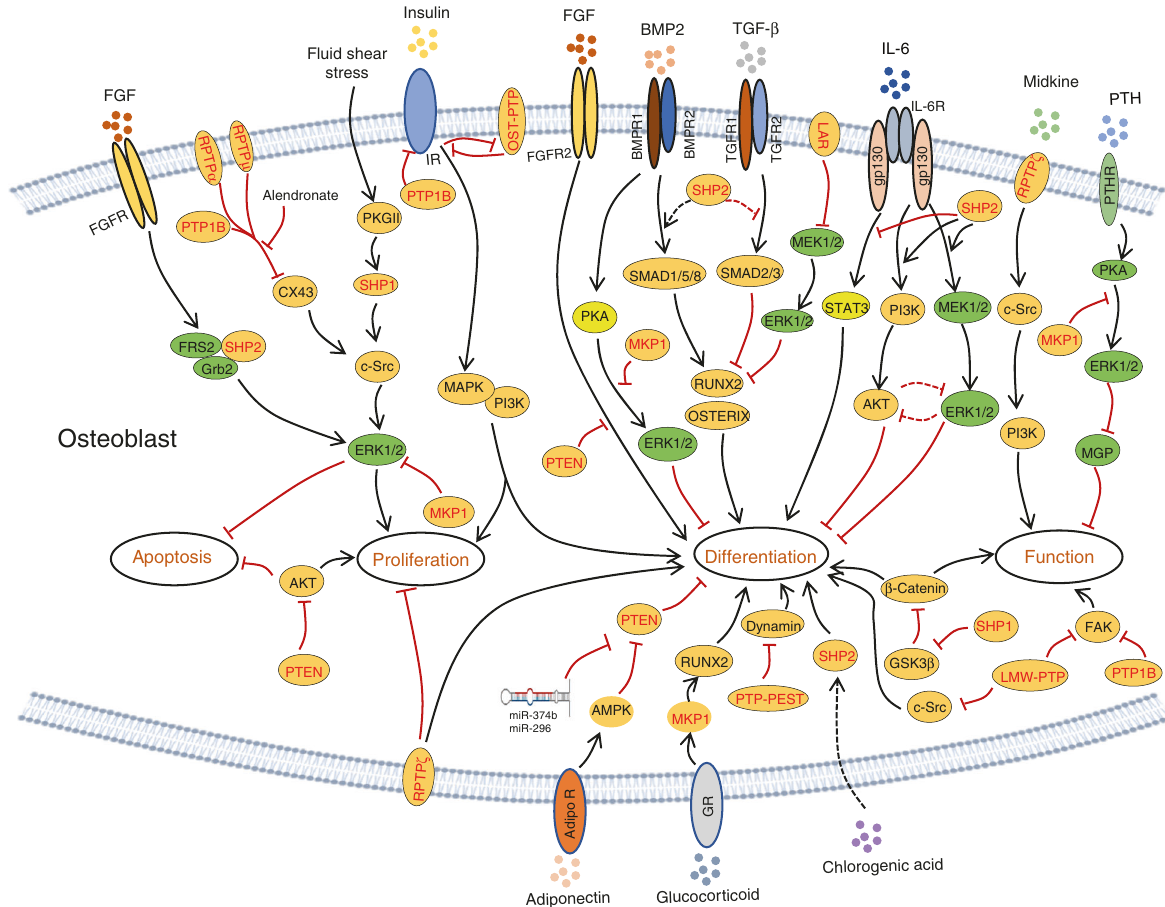
Fig. 5 PTPs modify multiple signaling pathways that differentially regulate the viability, proliferation, differentiation, and function of osteoblastic cells. Established signaling pathways in OBs are connected by lines with arrows indicating “ promotion ” and “ ┴ ” indicating inhibition. PTPs involved in each signaling pathway are marked in